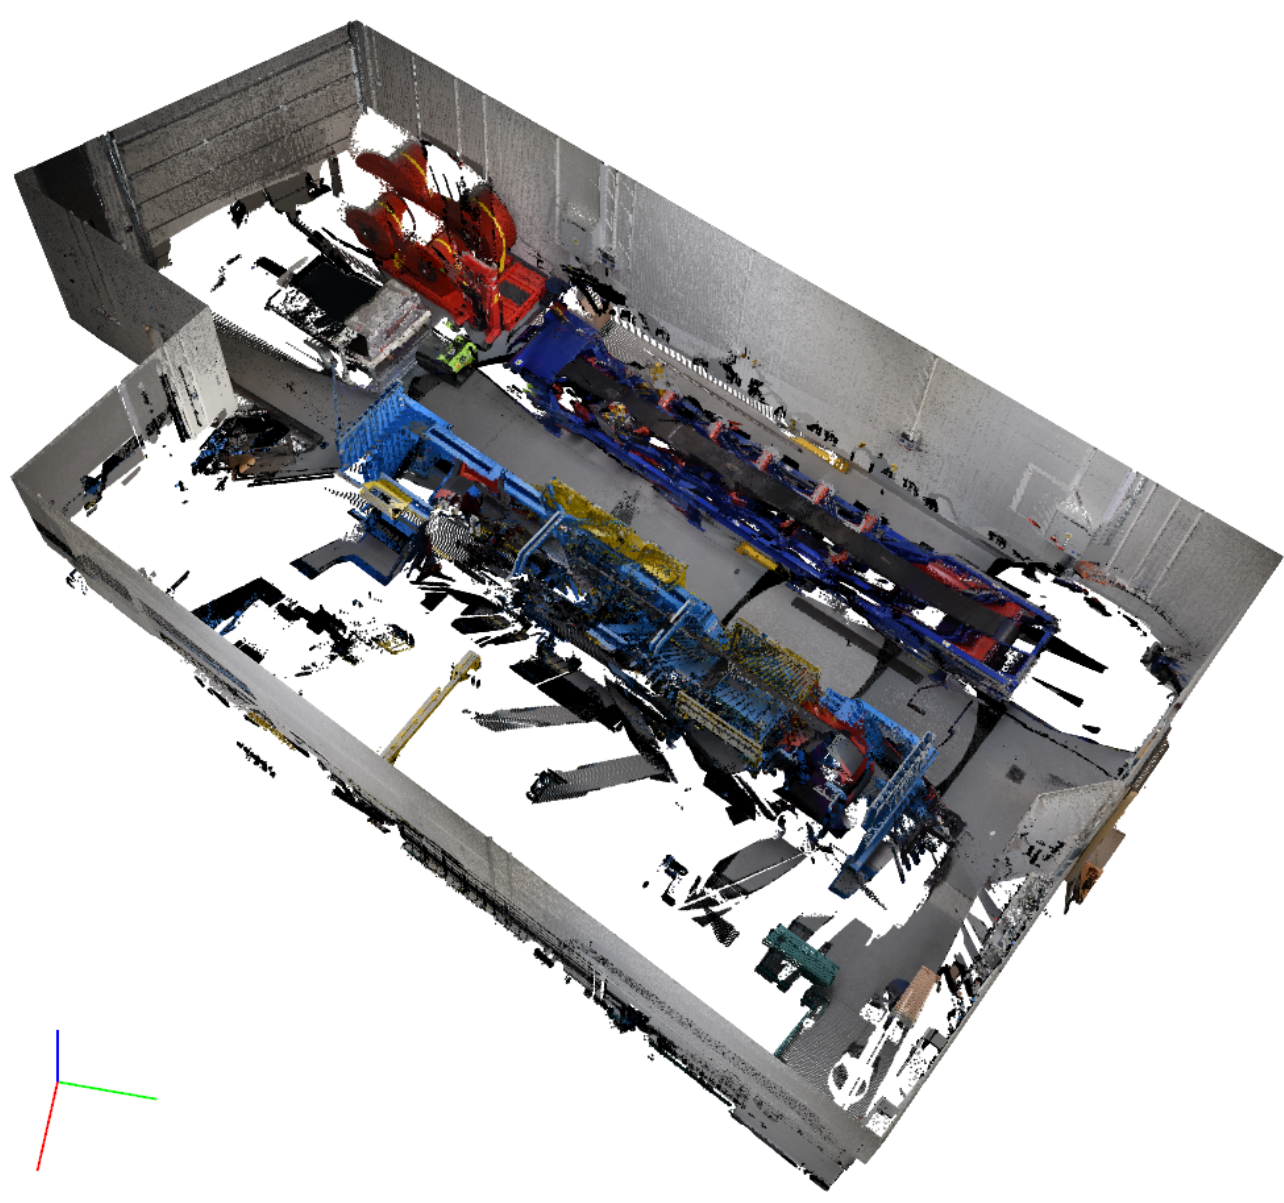
Figure 10. Point cloud of the lab with the belt